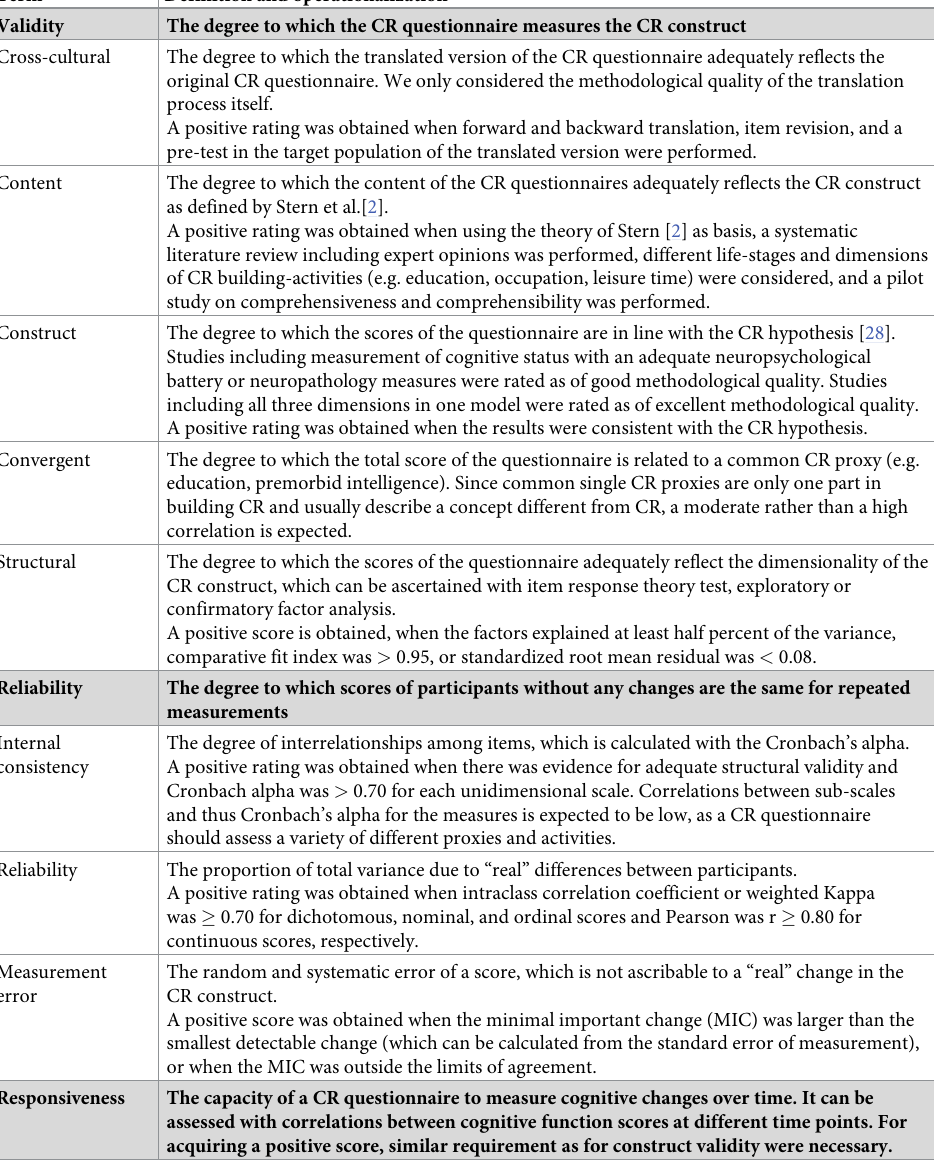
Table 1. Definition and operationalization of measurement properties (adapted from COSMIN [26,27] and Rainey et al.[29]). CR: Cognitive